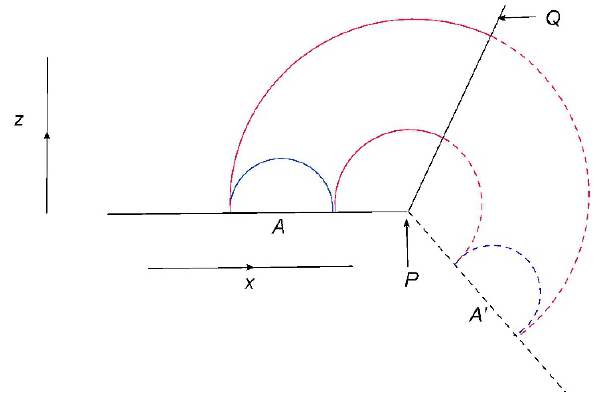
Figure 2 . Subsystem A and its mirror image A 0